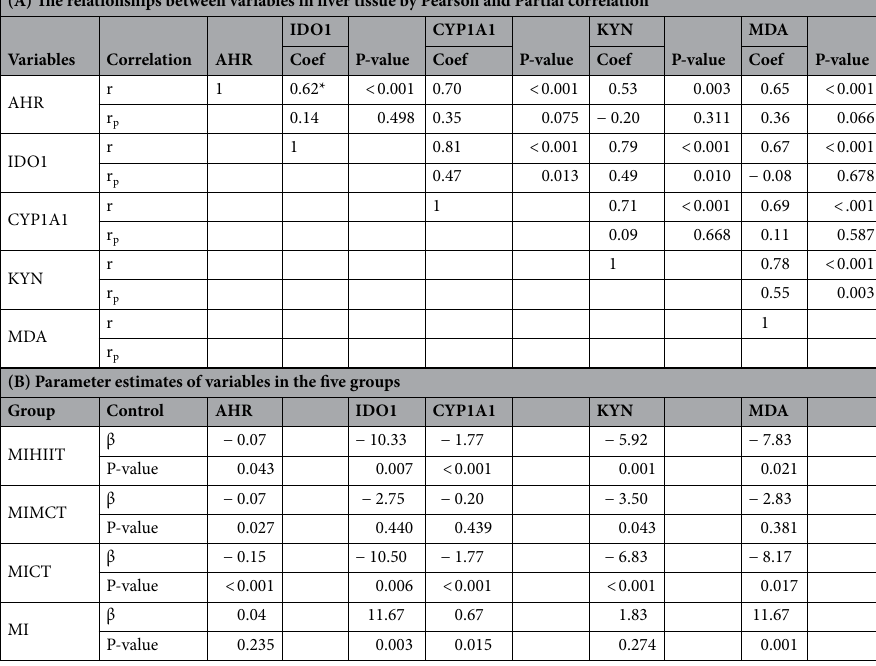
Table 3. Relationships between variables and parameter estimates. r Pearson correlation, rp Partial correlation, Coef Coefficient, β Parameter